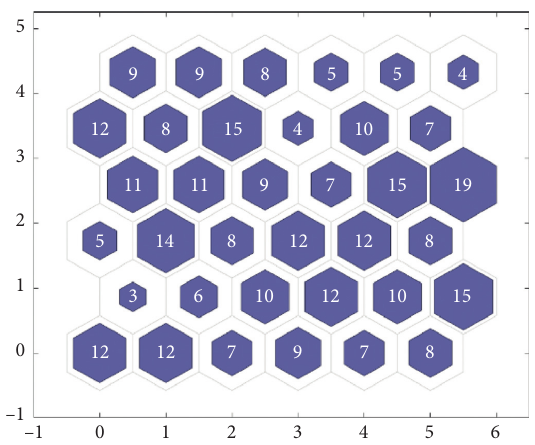
Figure 10: The number of stations covered by SOM neurons.